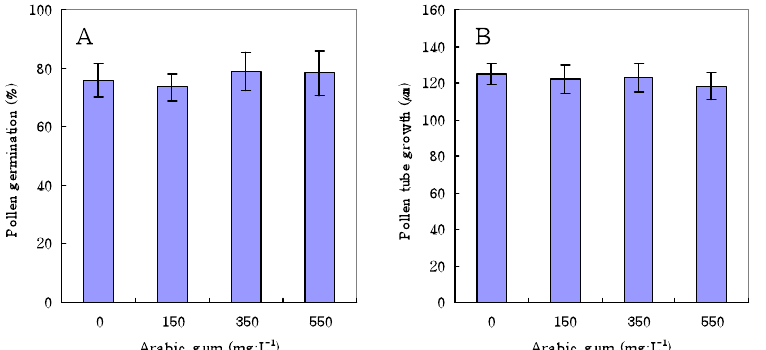
Fig. 3: Effects of arabic gum concentrations in the pollen liquid diluent on pollen germination rate (A) and pollen tube growth (B) of ‘Matua’ kiwi in vitro. Vertical bars represent ± SD. Results are from five replicates. Replicates above consist of approximately 50 pollen grains each.